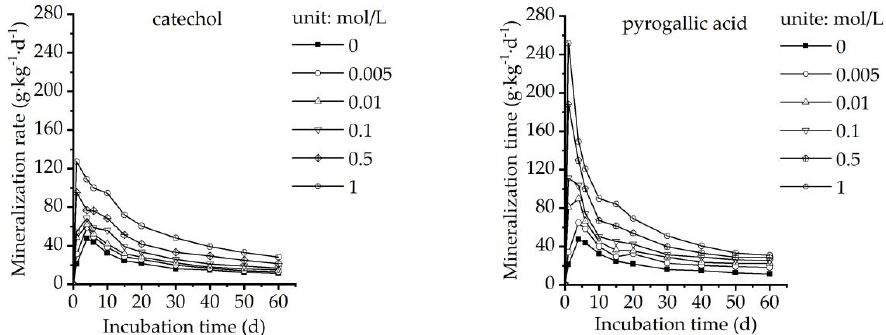
Figure 2. Effect of organic acids on the mineralization rate of the soil organic carbon.